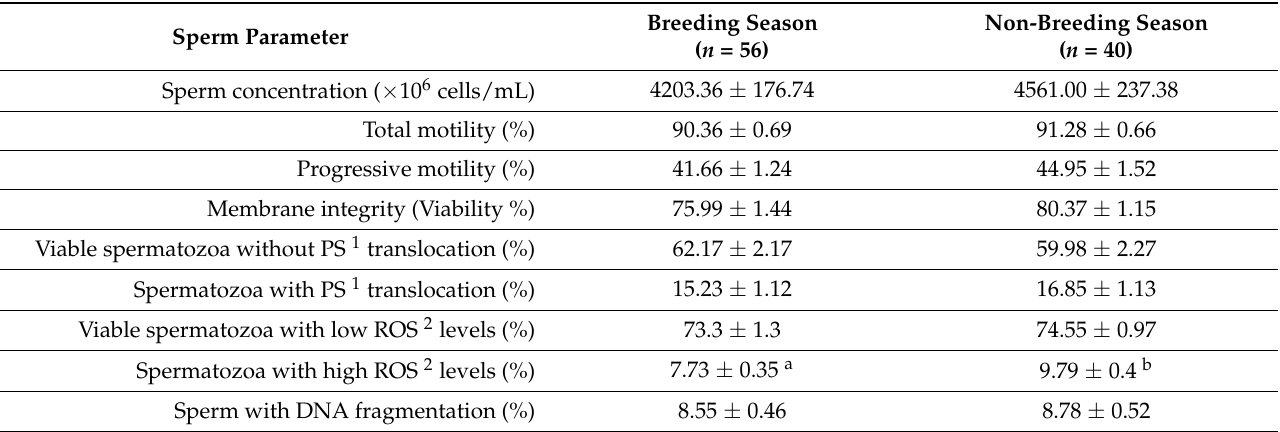
Table 2. Seasonal differences in seminal quality parameters in Rasa Aragonesa rams. Results are shown as mean ± SEM. Different letters indicate p < 0.05.